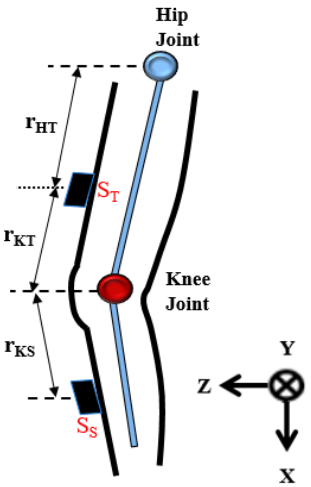
Figure 2. The coordinate system and the sensor model on the right leg. The X axis is the direction toward gravity, the Y axis is left-lateral direction and the Z axis is the walking direction. (S T denotes a sensor on the thigh. S S denotes a sensor on the shank. r HT means the distance from the hip joint to the thigh sensor. r KT means the distance from the knee joint to the thigh sensor, and r KS means the distance from the knee joint to the shank sensor).